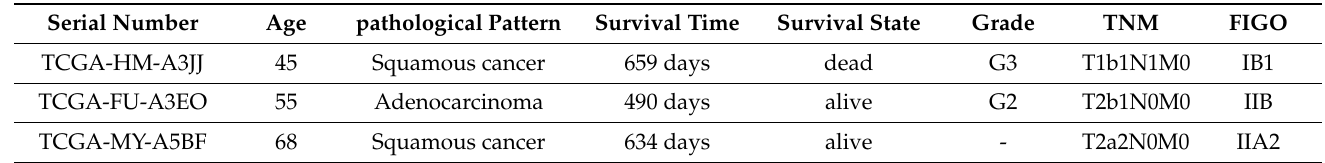
Table 5. The clinical data of three para-tumor samples.